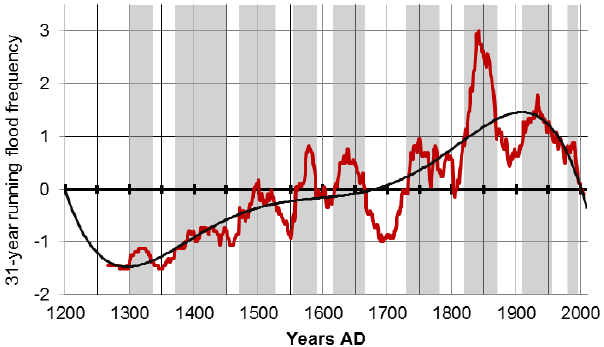
Figure 4. The 31-year running z -transformed flood frequencies of the Bavarian Foreland. Grey bars label flood-rich periods #1–#9, the black graph indicates the polynomial of 5th degree.